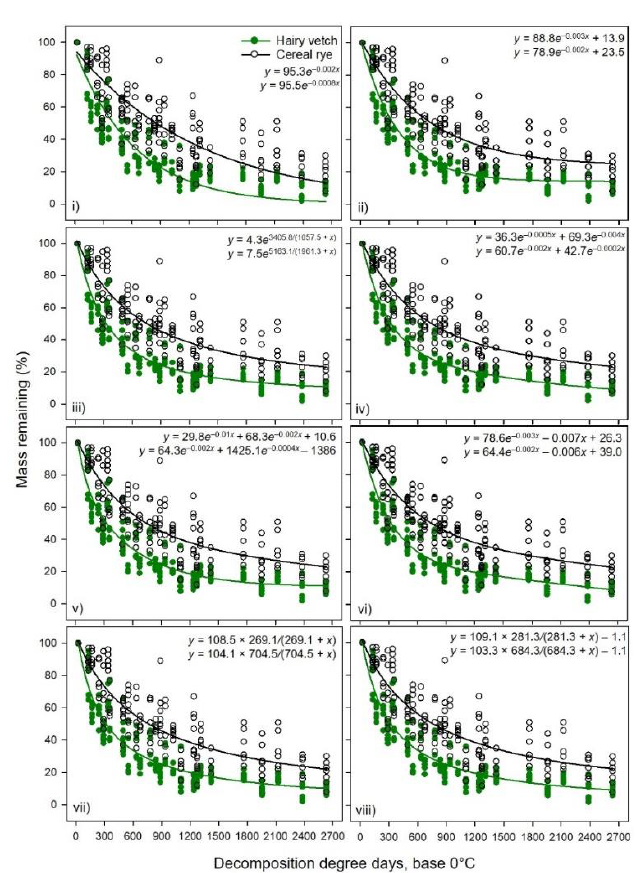
Figure 1. Exponential and hyperbolic decay models explaining percent mass remaining of hairy vetch and cereal rye cover crop aboveground residue against cumulative decomposition degree days at 0 ◦ C base temperature. ( i ) Two-parameter single exponential, ( ii ) three-parameter single exponential, ( iii ) modified three-parameter single exponential, ( iv ) four-parameter double exponential, ( v ) five-parameter double exponential, ( vi ) four-parameter single exponent with linear combination, ( vii ) two-parameter hyperbolic, and ( viii ) three-parameter hyperbolic. The upper equation represents hairy vetch and the lower cereal rye. Data were pooled from Exp. 1 and 2. All models were significant at P < 0.0001.